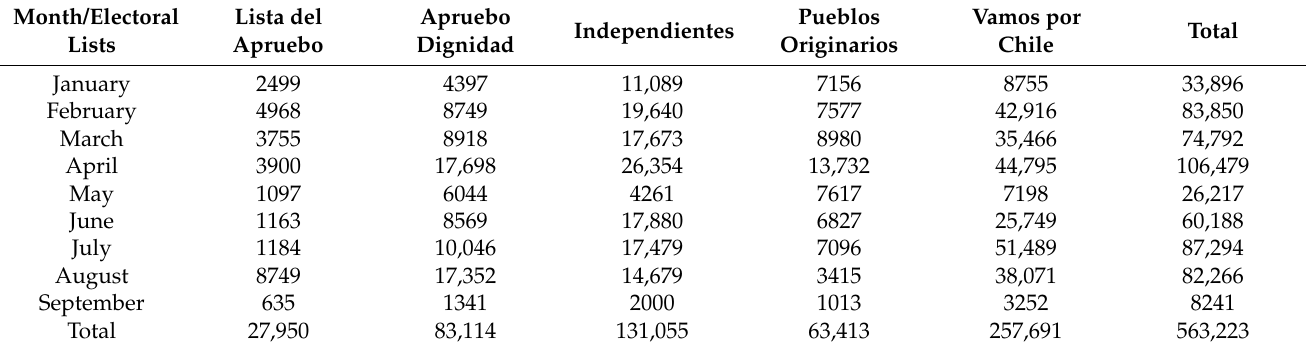
Table 2. Subcorpus of Twitter messages with hate speech detected by electoral lists